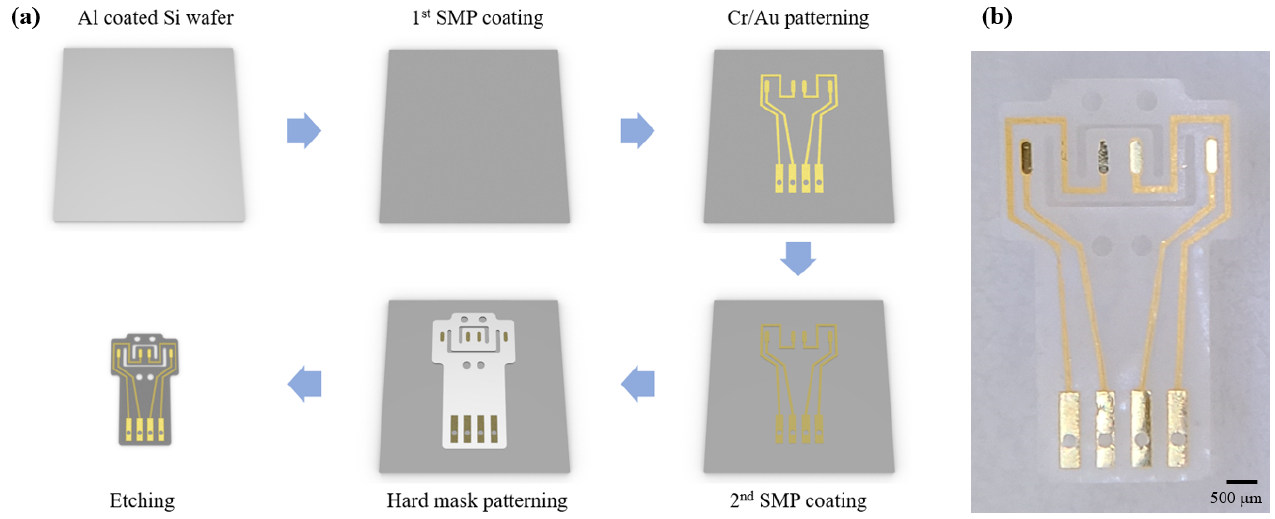
Figure 1. Fabrication process of the DCNI: ( a ) Schematic of the fabrication procedure; ( b ) Fabricated DCNI.